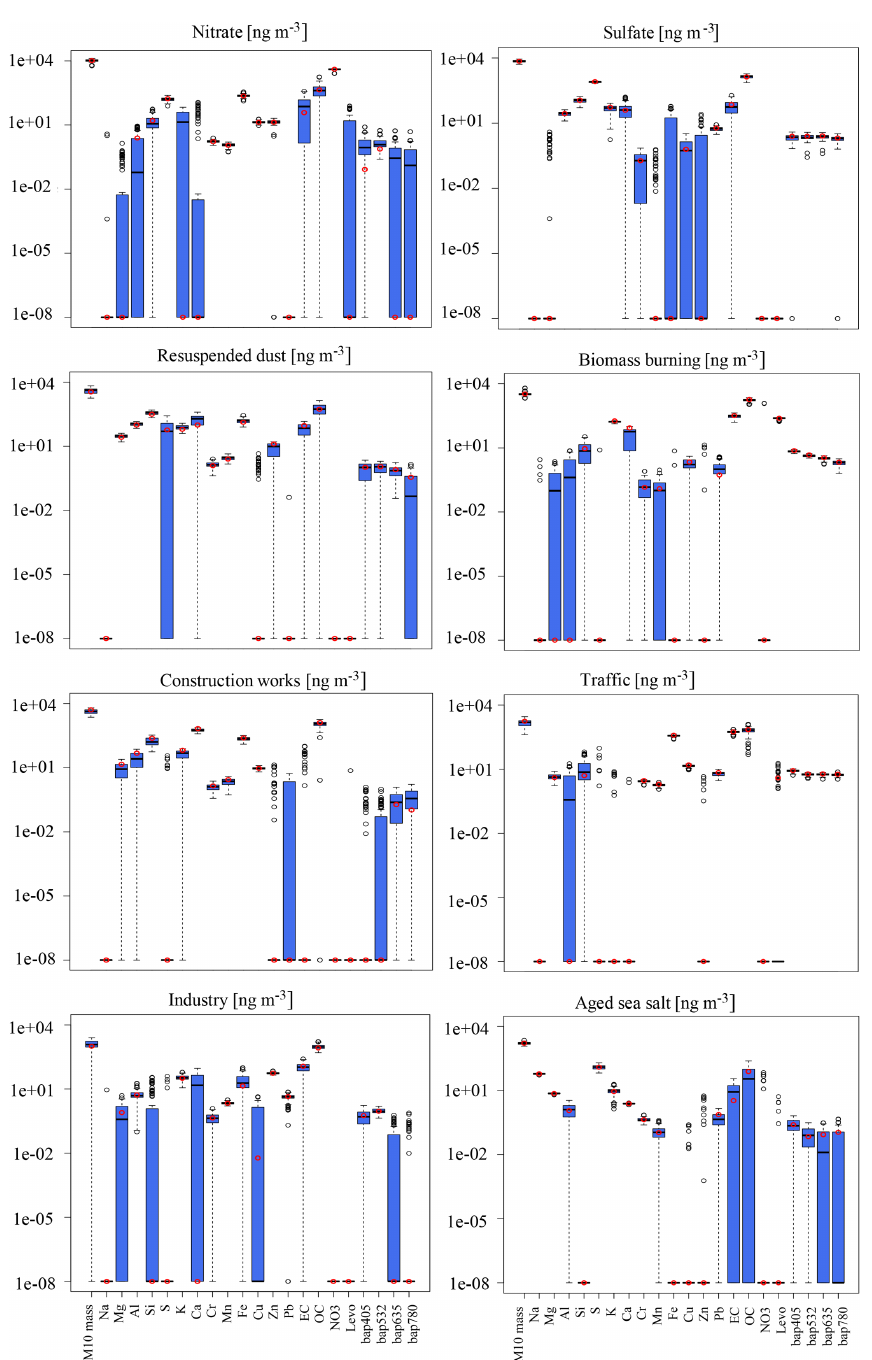
Figure 5. Box plot of the bootstrap analysis on the eight-factor constrained solution. The red dots represent the output values of the solution of the model; the black lines the medians from the bootstrap analysis; the blue bars the 25th and 75th percentiles; the dotted lines the interval equal to 1.5 times the interquartile range; and the black dots the outliers from this